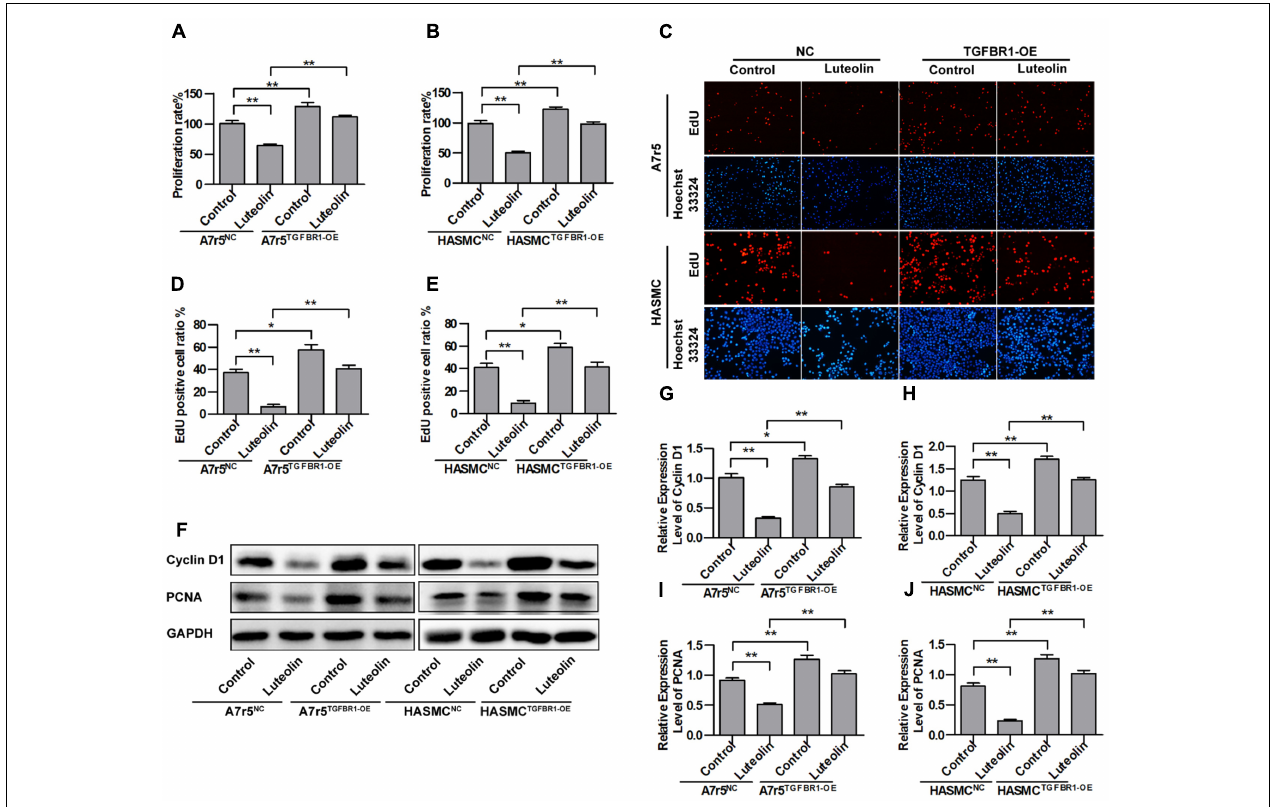
FIGURE 5 | Overexpression of TGFBR1 partially blocks the inhibitory effect of luteolin on vascular smooth muscle cell (VSMC) proliferation. (A , B) A7r5 and HASMC cells, respectively, were incubated with TGFBR1 overexpression adenovirus vector and GFP control adenovirus for 48 h and then treated with luteolin (40 µ M) for 48 h. Then, the proliferation of VSMCs was tested by MTS assays ( n = 6). (C) EdU proliferation assay. The red regions (EdU) in the images represent proliferating cells, and the blue regions (Hoechst 33324) represent the nuclei of all cells. (D , E) Percentage of EdU-positive VSMCs ( n = 3). (F) A7r5 and HASMC cells, respectively, were incubated with TGFBR1 overexpression adenovirus vector and GFP control adenovirus for 48 h and then treated with luteolin (40 µ M) for 24 h. the expression levels of Cyclin D1 and PCNA were tested by western blotting. (G – J) Relative expression levels of Cyclin D1 and PCNA ( n = 3). Data are shown as the mean ± SD. ∗ P < 0.05, ∗∗ P <